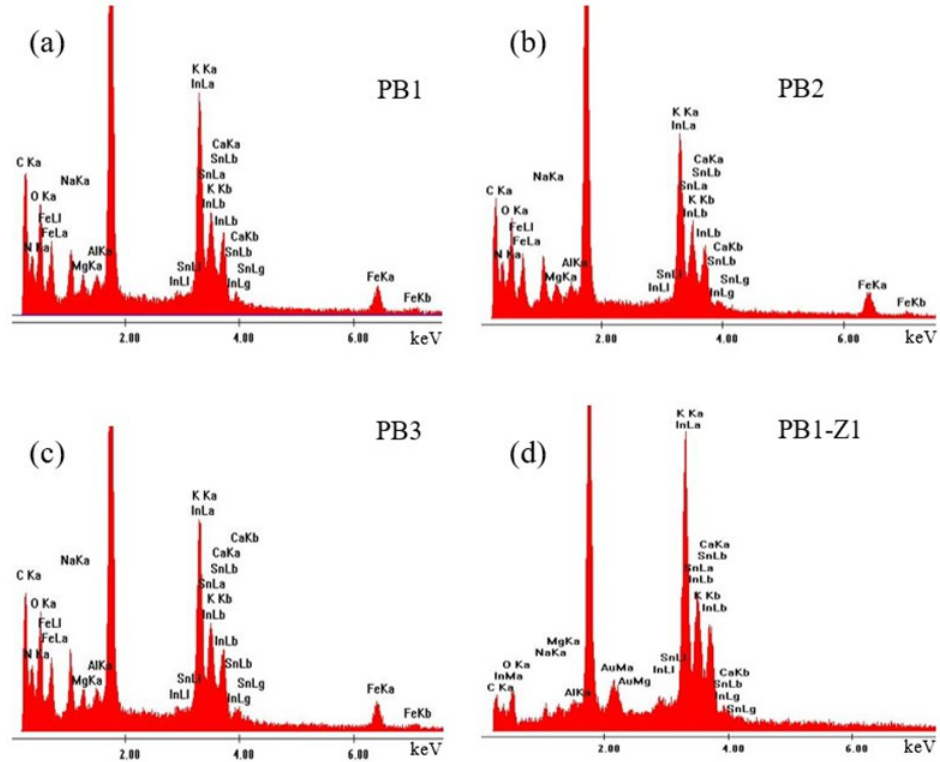
Figure 3. ( a – c ) Energy dispersive X-ray spectroscopy (EDX) spectra measured in the PB films deposited over ITO/Glass substrates, using DC chronoamperometry (PB1), symmetric pulse (PB2), and non-symmetric pulse (PB3) electrodeposition techniques. In ( d ), the EDX spectrum of the ITO/Glass substrate is shown, for comparison. Table 2. The normalized data regarding the EDX spectra of the PB films of Figure 3.